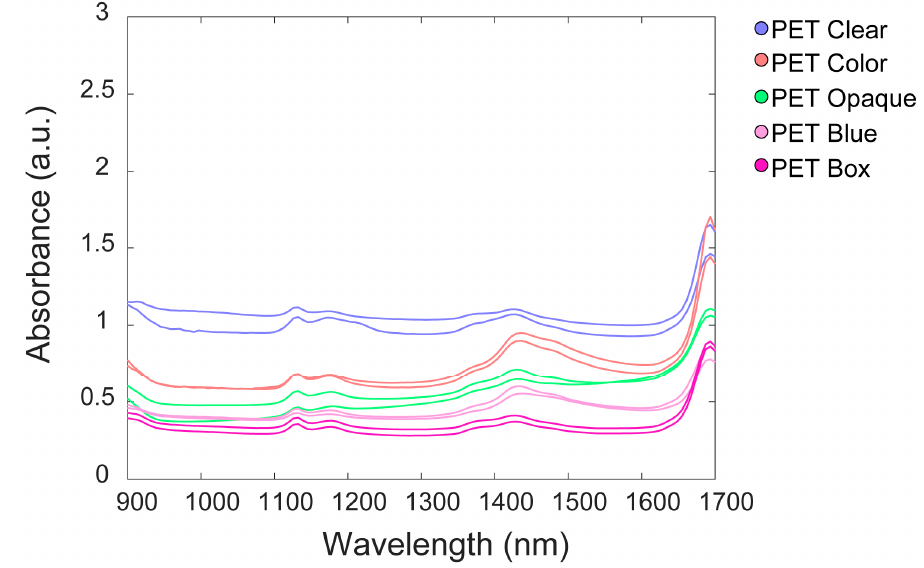
Figure A2. Representative NIR spectra of two random samples for each kind of PET commodity.